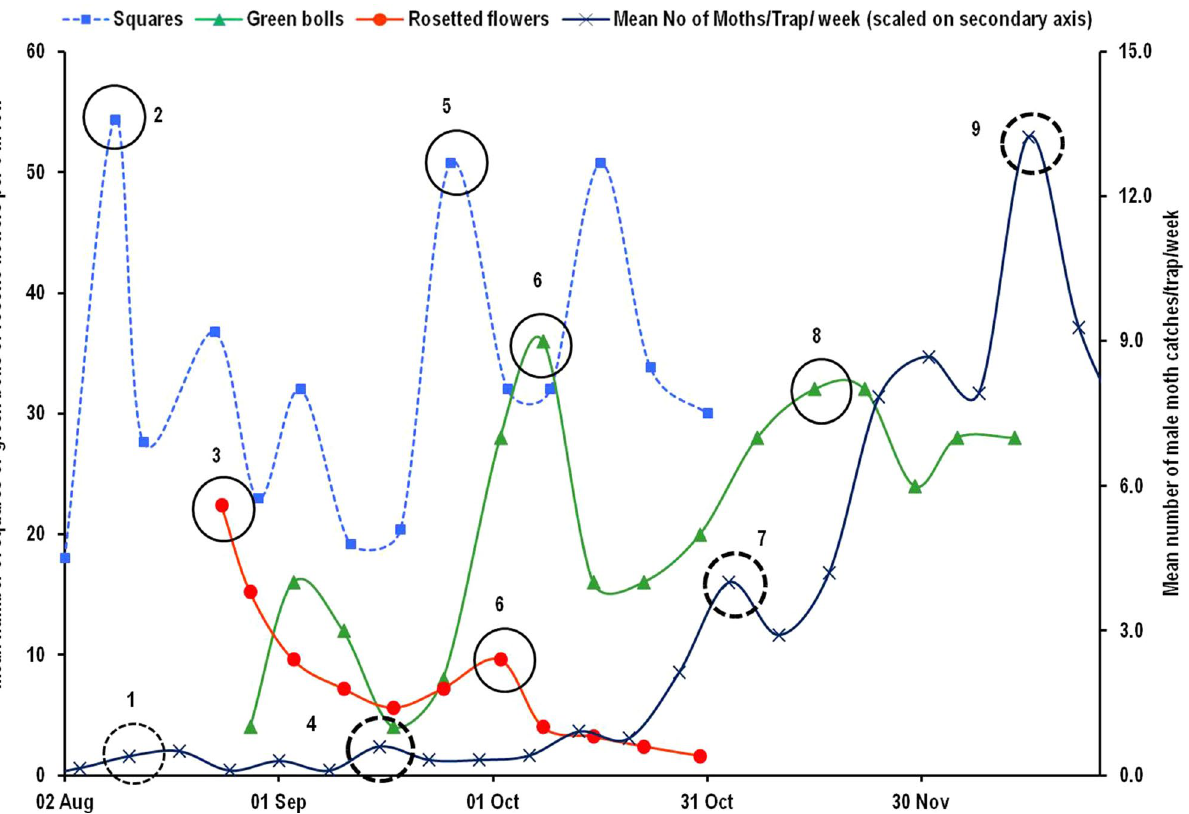
Figure 2. Estimation of number of generations completed by pink bollworm in a cotton season based on DD accumulations between successive male moth catch peaks obtained in sex pheromone traps during the year 2018–19 at Nagpur (India). The DD accumulations were started from 2 weeks prior to rosette flower appearance in field. The dotted circle no. 1 denotes the availability of male moths to mate with female moths to oviposit on susceptible squares in circle no. 2 which gave rise to rosetted flowers approx. 2 weeks later as indicated in circle no. 3 from which emerged the first flush of moths (F1) produced within current season’s cotton crop, indicated by circle no. 4. The cycle is repeated and giving rise to F2 and F3 moths as indicated in circle nos. 7 and